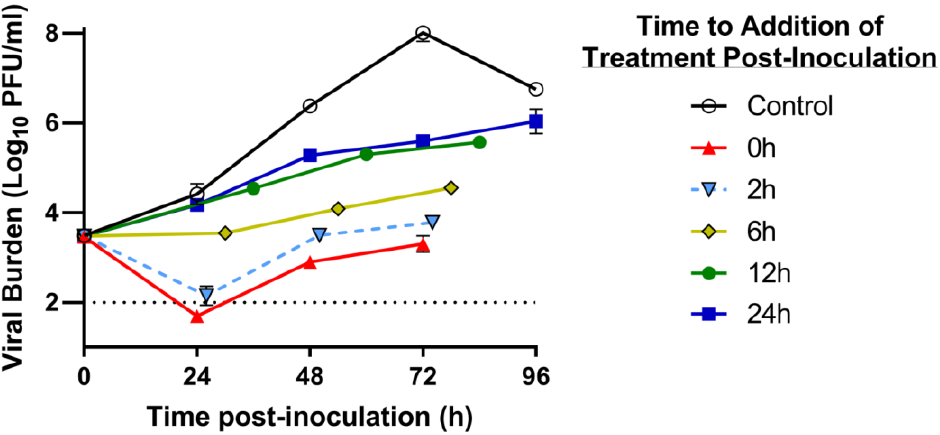
Figure 2. The influence of time to initiation of treatment on the antiviral effect of ribavirin (RBV) plus Interferon- α (IFN) when administered at exposures associated with the clinical regimens against DENV2 in the Hollow fiber infection model (HFIM) system. Huh-7 cells were mixed with DENV at a multiplicity of infection of 0.001 PFU/cell and inoculated in the HFIM. Drug exposure was the same between all treatment arms, with the exception of the control (untreated) arm. The combination regimen was administered into HF cartridges at different times post-inoculation (0 h, 2 h, 6 h, 12 h, and 24 h). Supernatant samples were collected from the system for three days following drug administration and viral burden was quantified by plaque assay on Vero cells. Viral burden is reported as log 10 PFU/mL. Each data point represents the geometric mean of two independent samples and error bars correspond to one standard deviation. The assay limit of detection is represented by the dashed horizontal line.